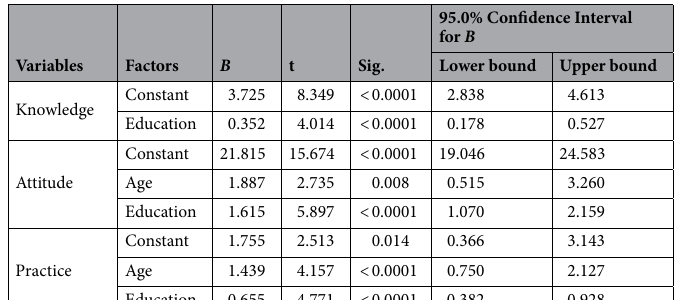
Table 5. Multiple linear regression analyses for predicting score of knowledge, attitude and practice.